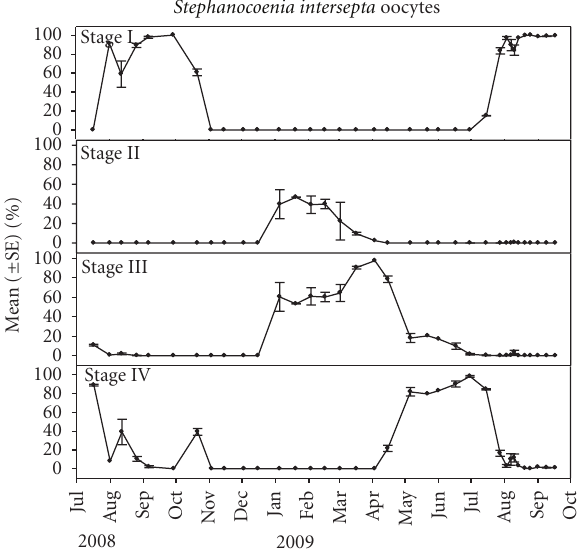
Figure 9: Stephanocoenia intersepta mean ( ± SE) percentages of oocyte per colony quantified through histological